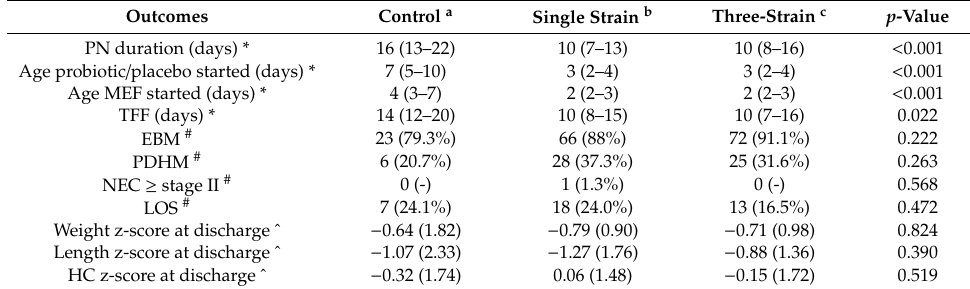
Table 2. Nutritional outcomes and growth at